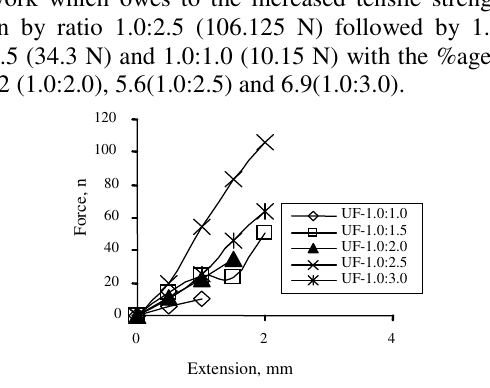
Figure 1(a). Tensile strength results of different ratios of UF resin